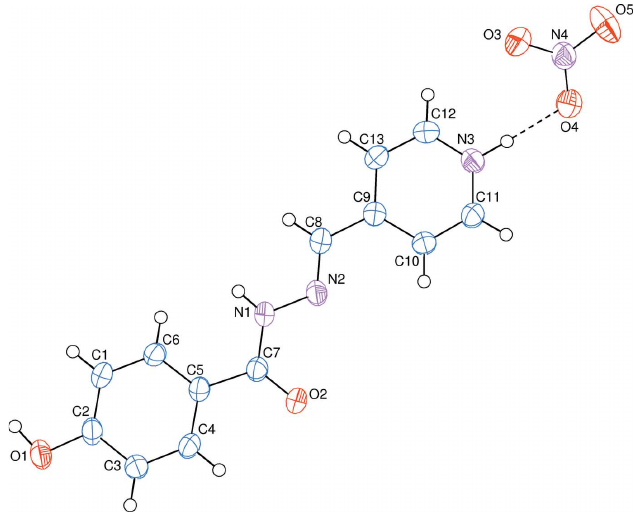
Figure 1 The molecular structure of the title aroyl hydrazone Schiff base salt, with the atom-numbering scheme. The N—H Pym (cid:2)(cid:2)(cid:2) O N (Pym = pyridinium and N = nitrate) hydrogen bond (see Table 1) is shown as a dashed line. Displacement ellipsoids are drawn at the 50% probability level.